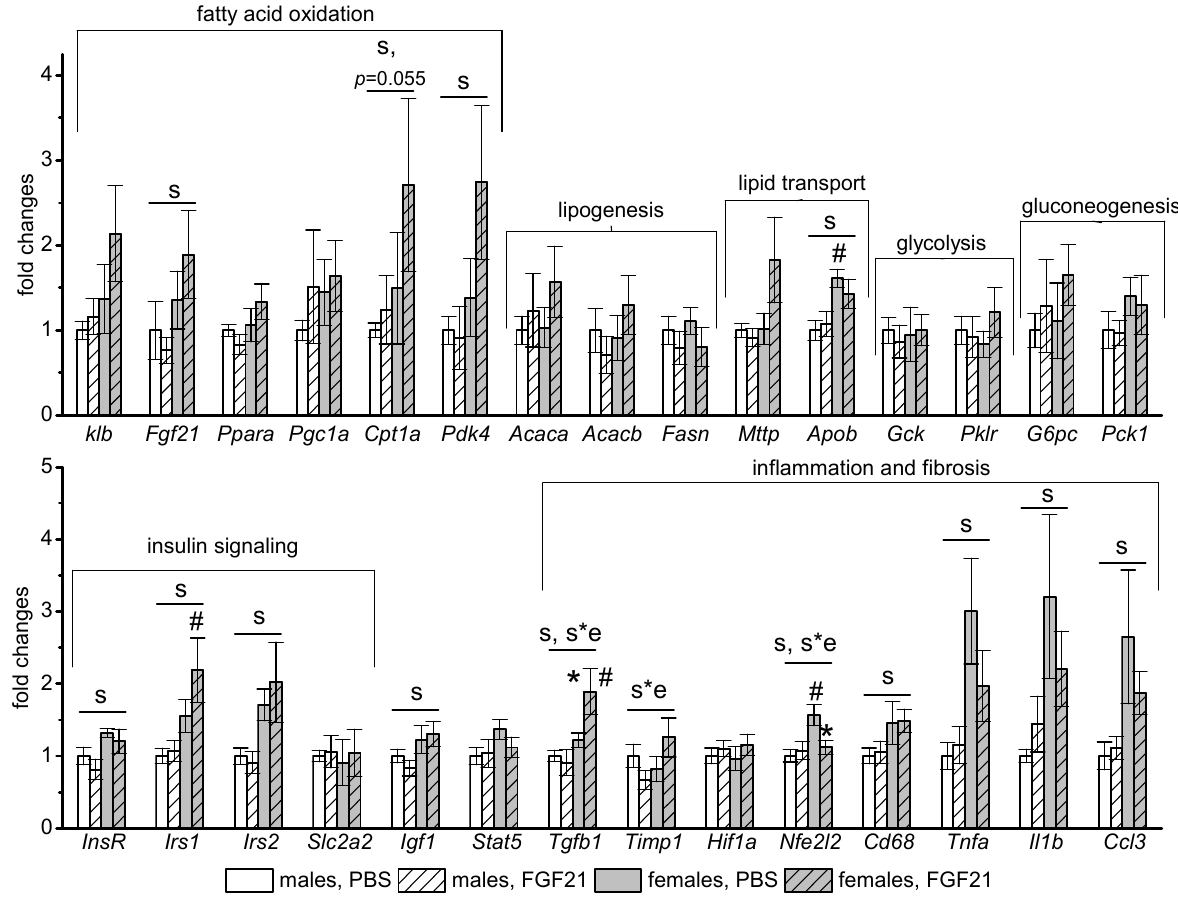
Figure 4. Influence of FGF21 administration on liver gene expression in obese A y male and female mice. Data are presented as mean ± SE. Mice were administered FGF21 for 7 days. Significant influence ( p < 0.05) of factors “e” (administration of PBS or FGF21), “s” (sex), and “s*e”, two-way ANOVA, are indicated in the plot.